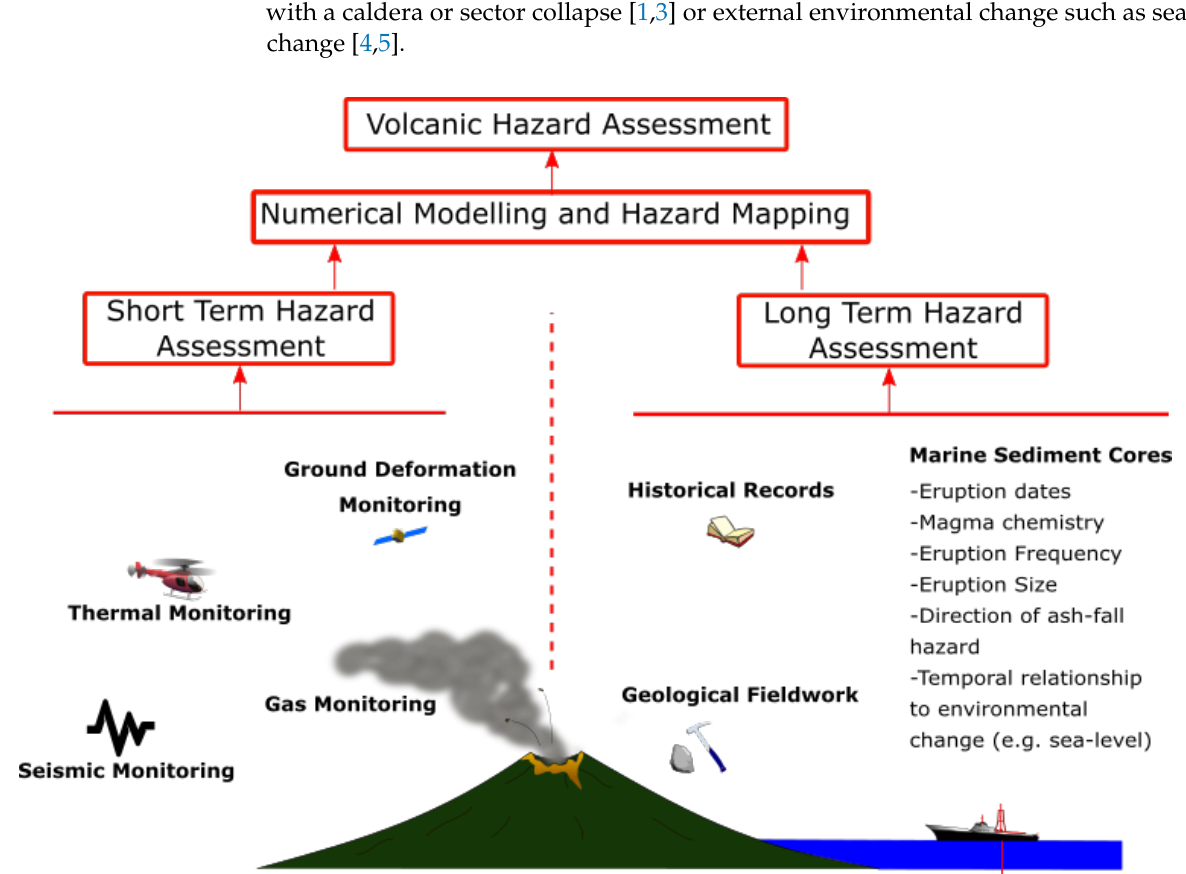
Figure 1. Schematic representation of the sources of information contributing to a volcanic hazard assessment for an island or coastal volcano, with the details of the types of information which can be provided by marine sediment cores.